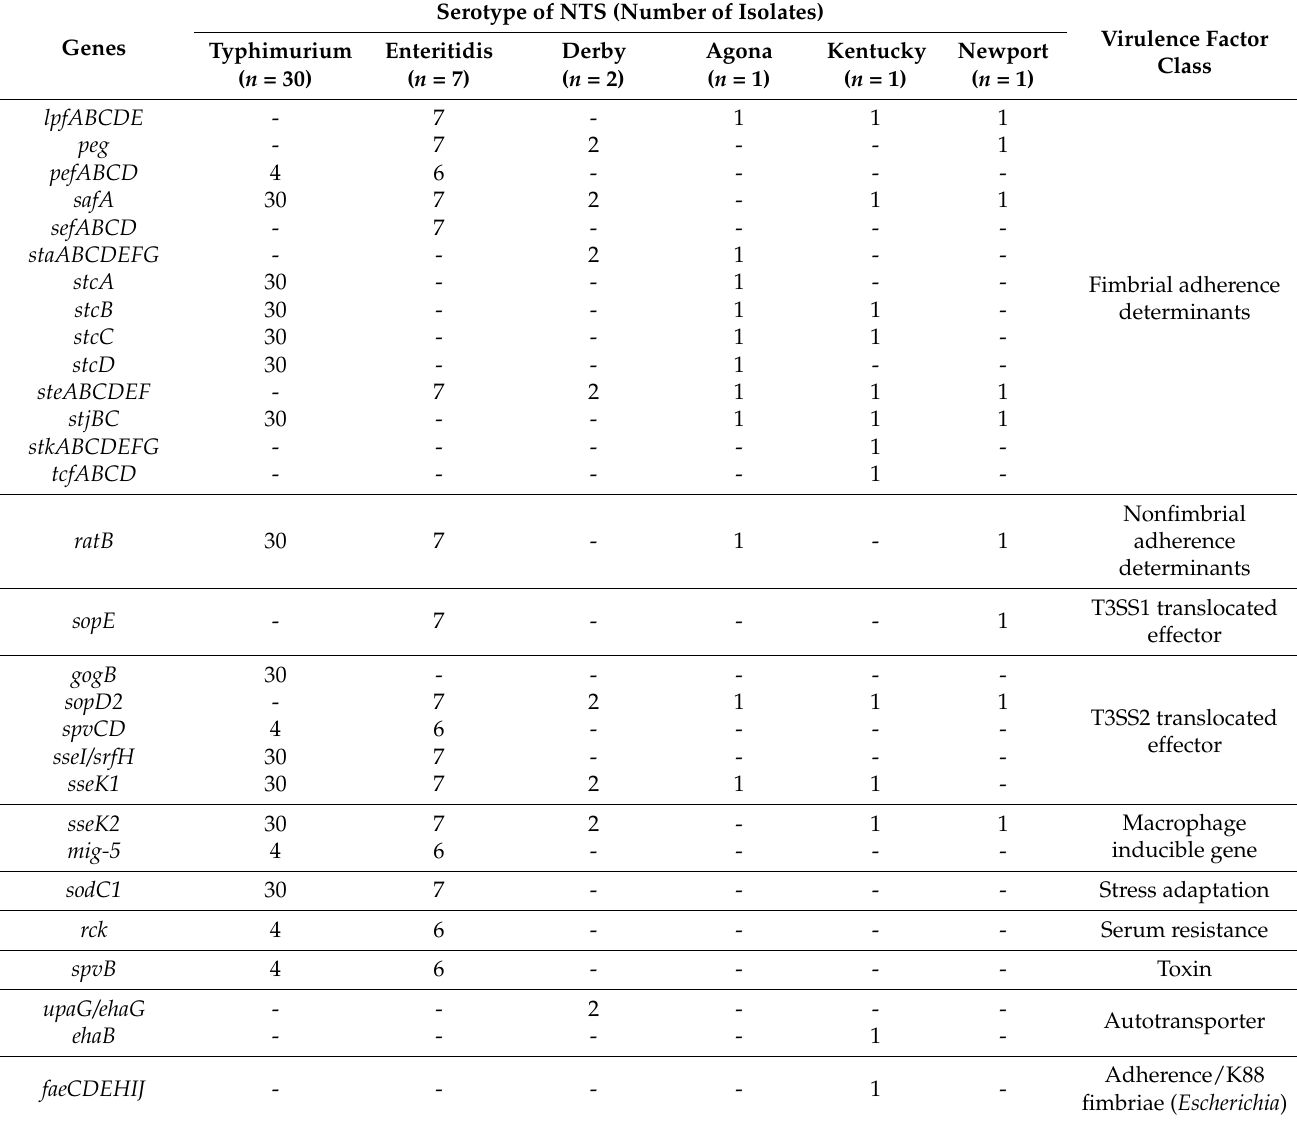
Table 1. Prevalence of the serotype-specific virulence-related genes in human non-typhoidal Salmonella (NTS) isolates from Armenia identified by VFanalyzer